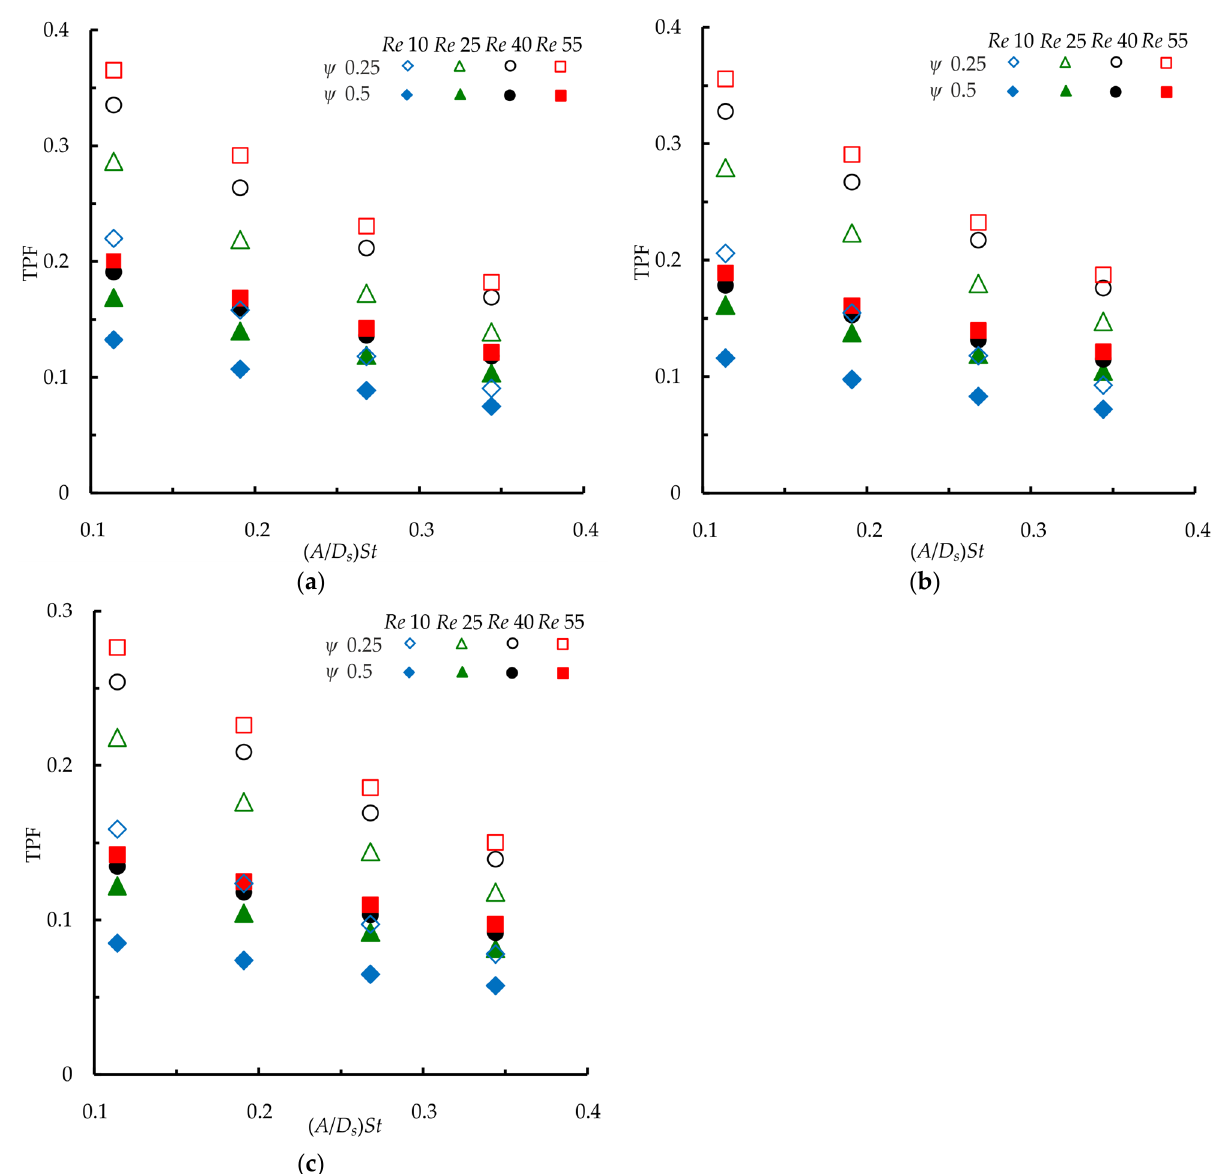
Figure 17. The effect of the pulsating flow on the Thermal Performance Factor averaged over one period of pulsation for different porosities: ( a ) ε = 0.743. ( b ) ε = 0.864. ( c ) ε = 0.954.